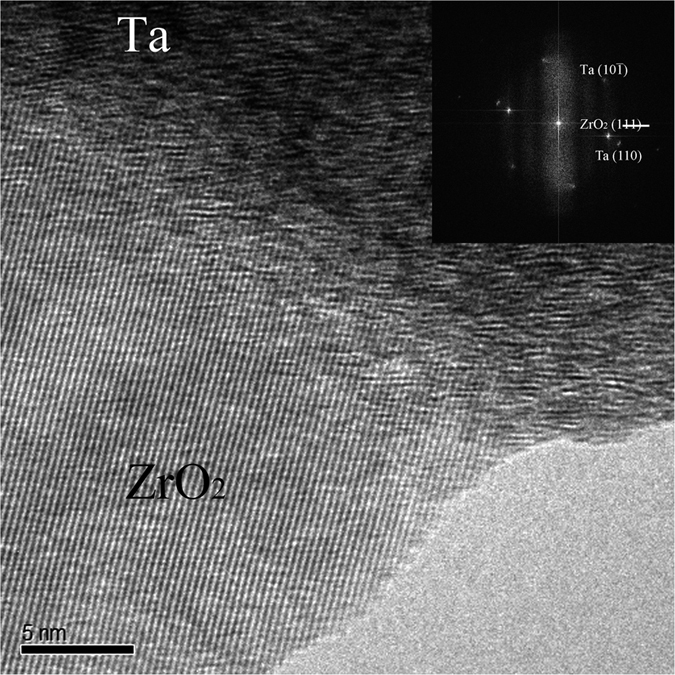
High resolution transmission electron micrograph of the ZrO2/Ta interface.